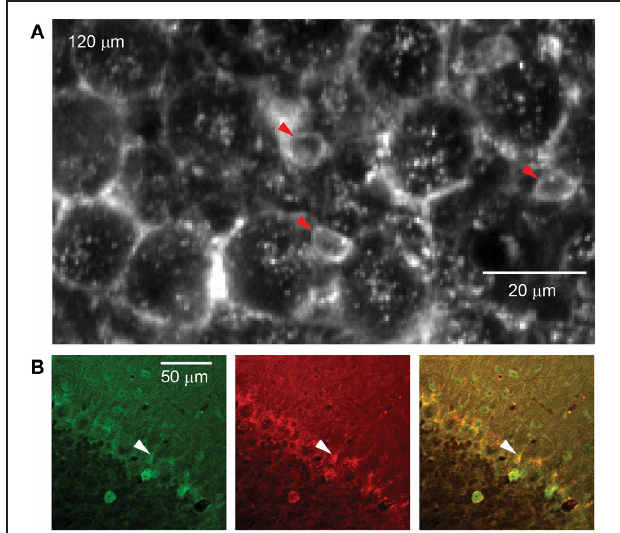
FIGURE 3 | rAAV-hSYN-D3cpv labels candelabrum cells of the PC layer. (A) The somata of candelabrum cells indicated by arrowheads are found between unlabeled Purkinje somata and brightly labeled axonal baskets. (B) Double labeling (superposition yellow) with anti-GABA (green) and anti-glycine (red) confirms identification as candelabrum cells. Number in the upper left corner indicates imaging depth.